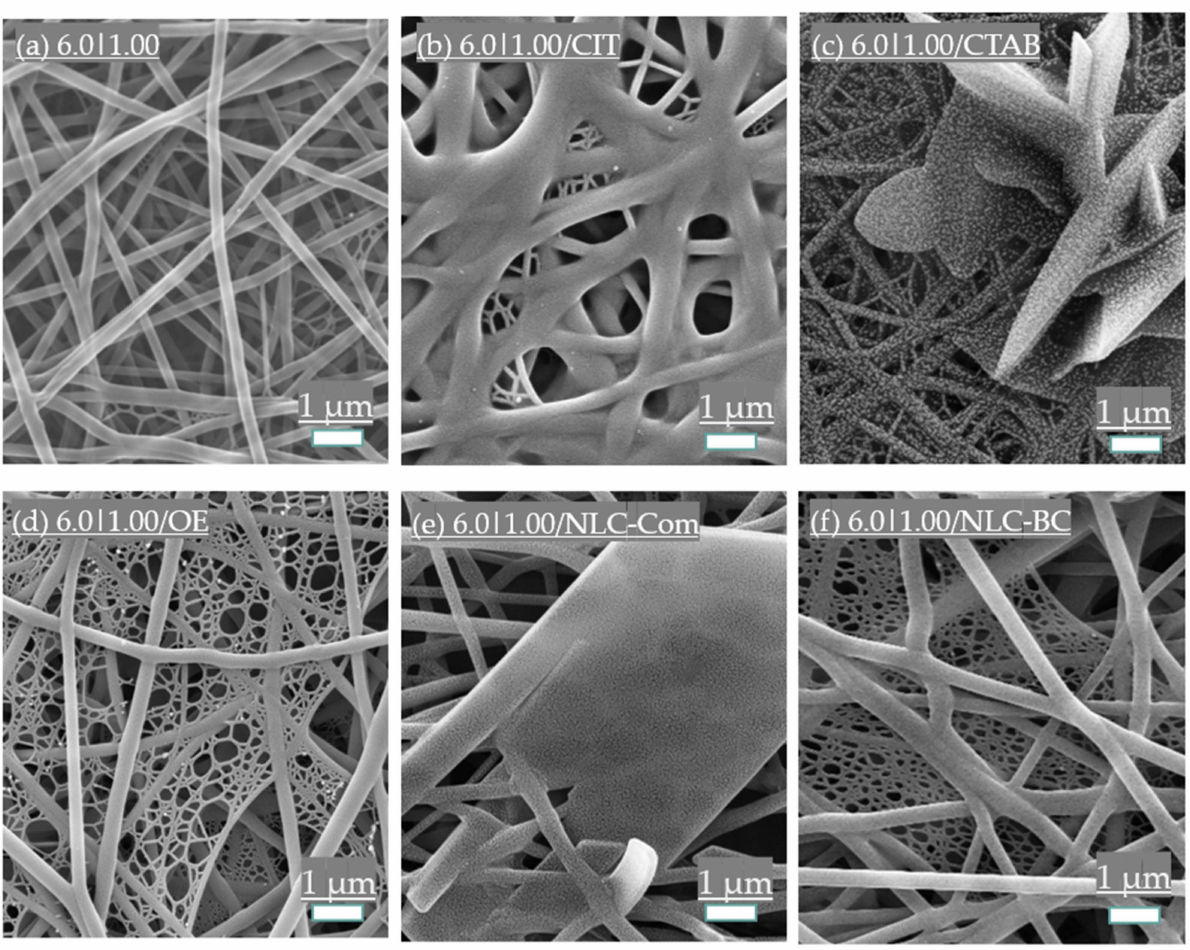
Figure 9. SEM images of the 6.0|1.00 solution ( a ) without additives and with 5% additions of ( b ) citric acid, ( c ) cetyltrimethylammonium bromide (CTAB), ( d ) essential oil of Lippia sidoides and L. sidoides loaded in nanostructured lipid carriers (NLC) used as solid lipids, ( e ) Compritol ® 888 ATO, and ( f ) blend of beeswax and carnauba